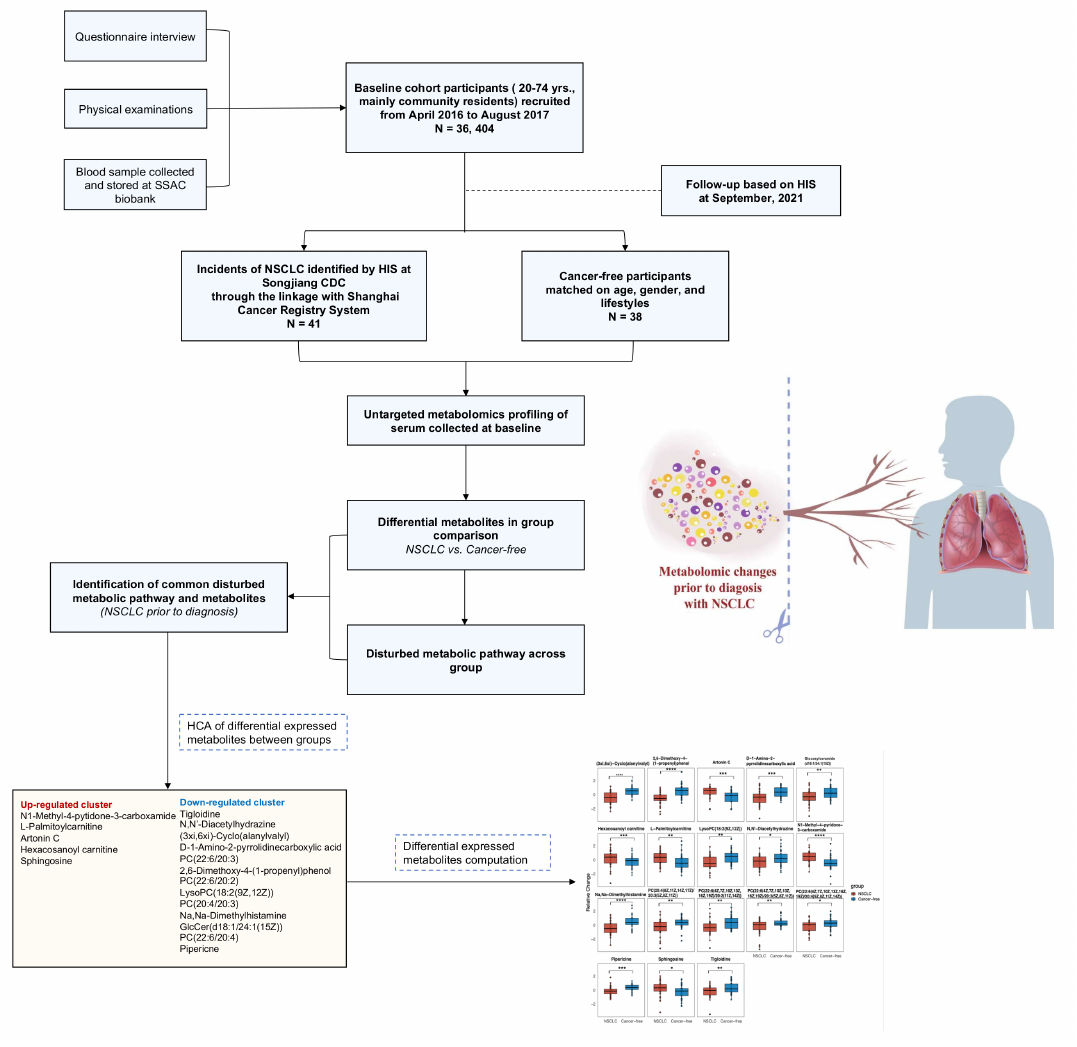
Figure 1. Flow chart of the study overview, subjects, and